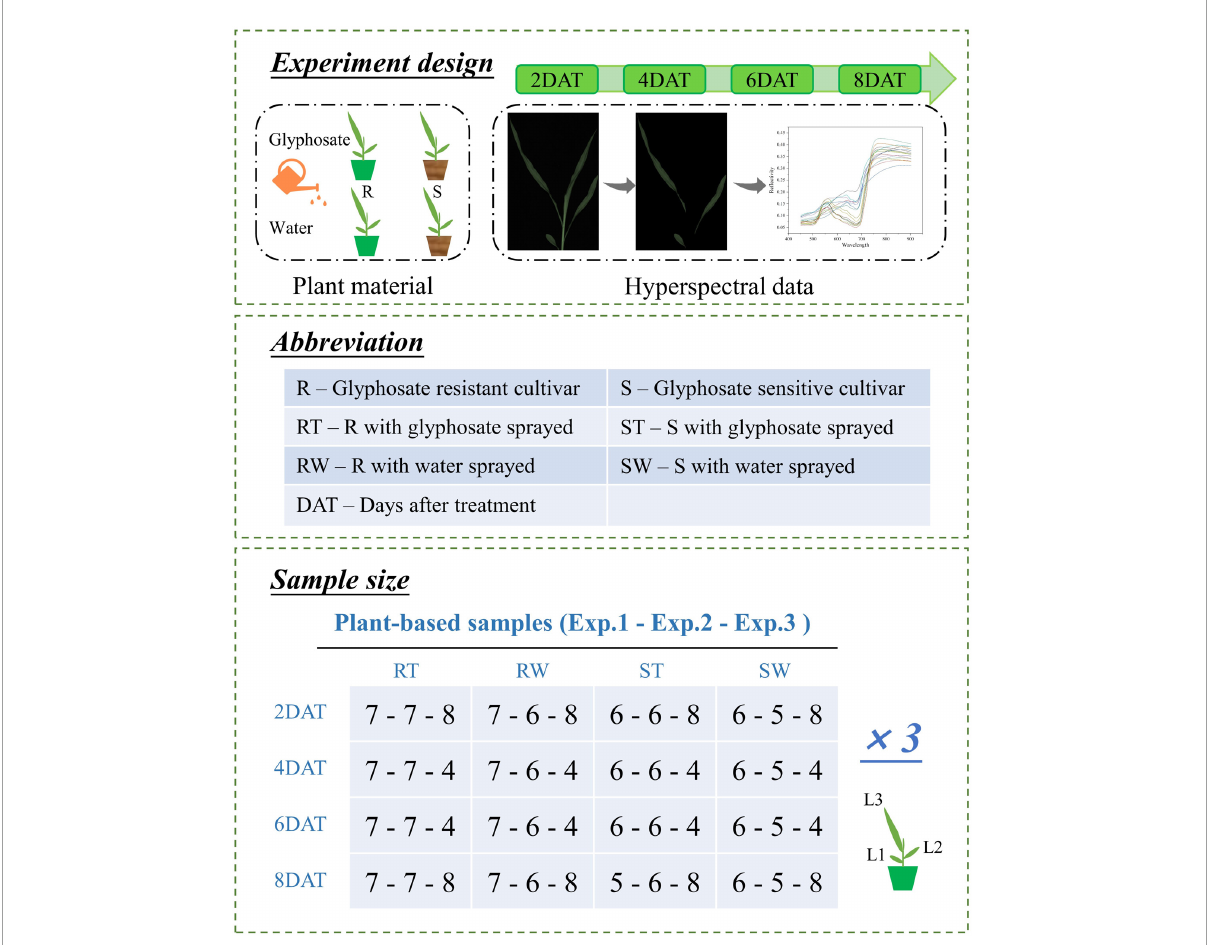
FIGURE1 Schematic diagram and detailed information for experiments. Three independent experiments were conducted in August, November, and December 2021, designated as Exp.1, Exp.2, and Exp.3, respectively. In each experiment, treatment group and control group were set up for both cultivars (glyphosate resistant and glyphosate sensitive cultivar). When maize plants grew to the three-leaf stage, the maize plants of treatment group were subjected to glyphosate, while the maize plants of control group were sprayed with water. Then time-series visible/near-infrared hyperspectral images of alive maize plants were collected at 2, 4, 6, and 8 days after treatment (DAT) by a line-scan hyperspectral imaging system. The sample size of each experiment was given in unit of maize